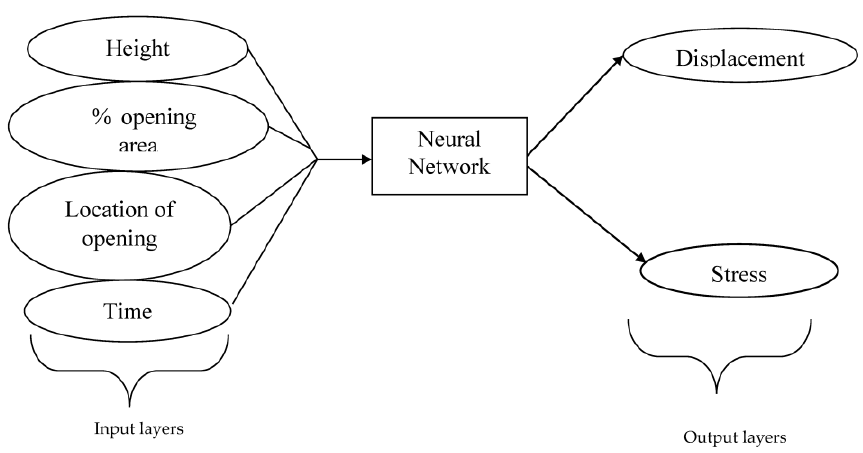
Figure 34. ANFIS structure for prediction.